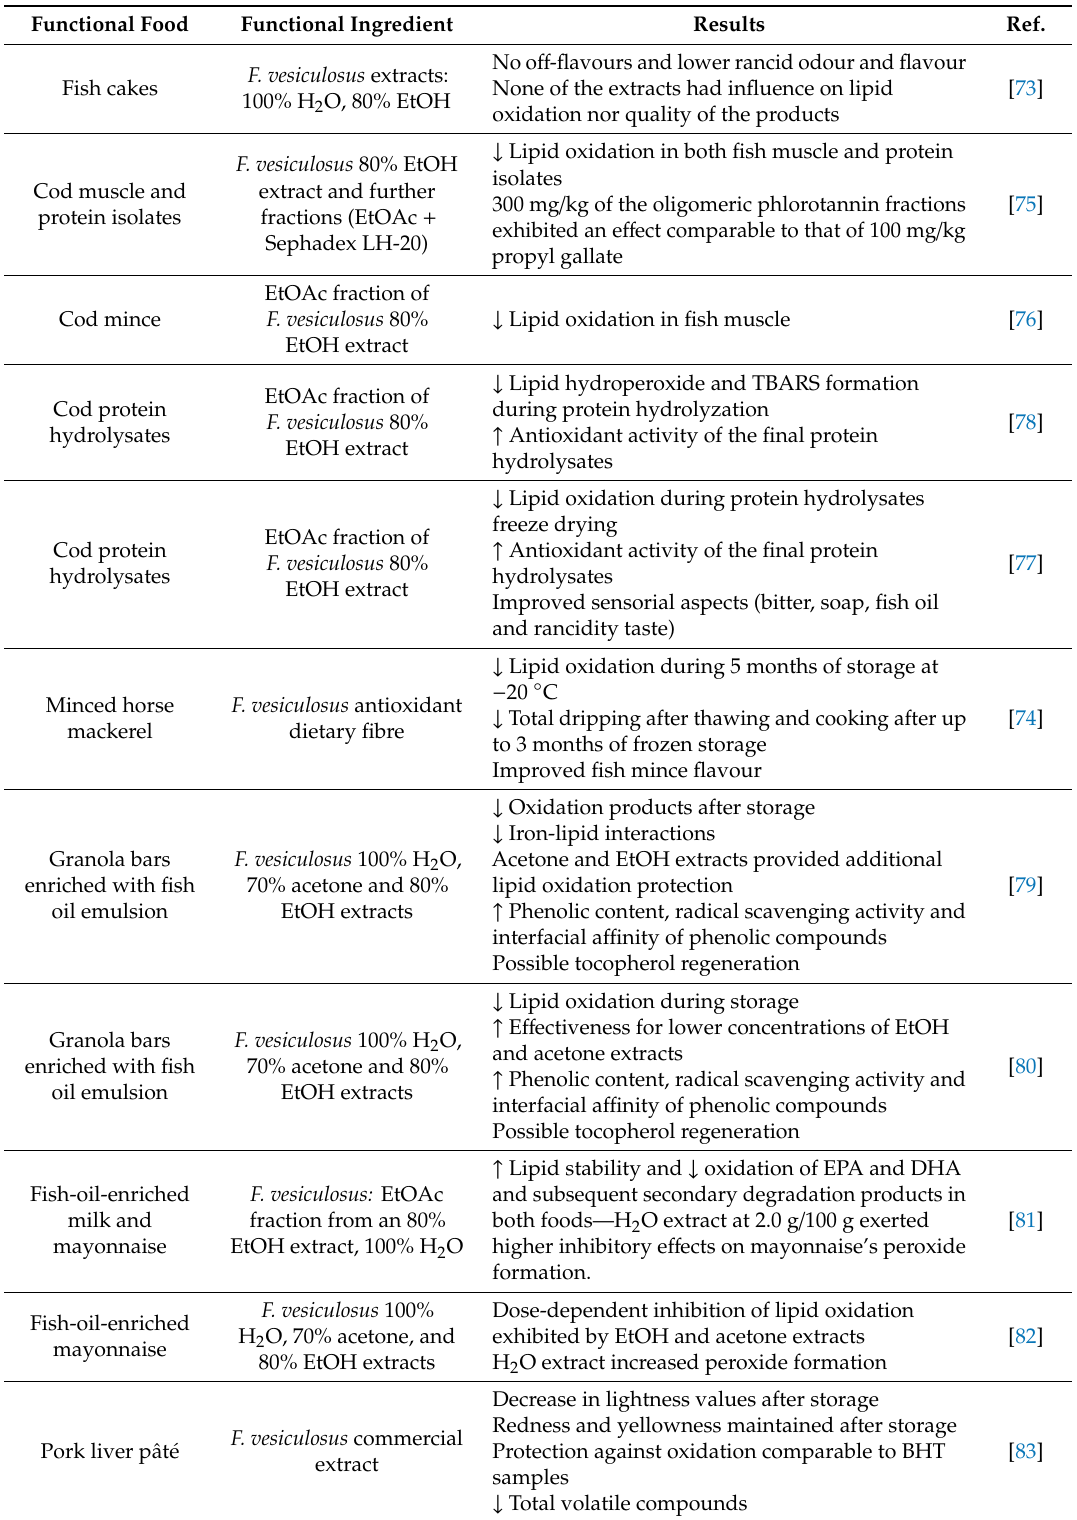
Table 1. Selected studies reporting the e ff ects of the incorporation of F. vesiculosus or isolates as ingredients in di ff erent food